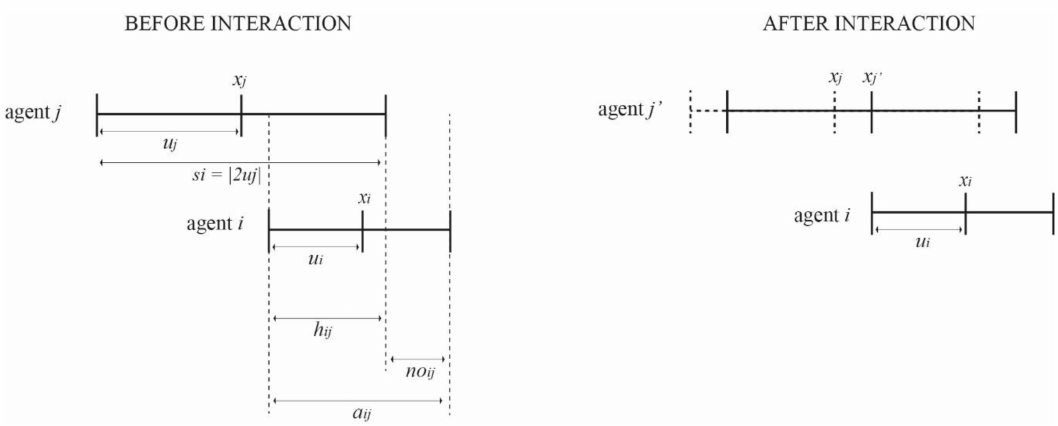
Figure 2. The influence of individual i on individual j based on the “relative agreement rules” (adapted from De ff uant et al.